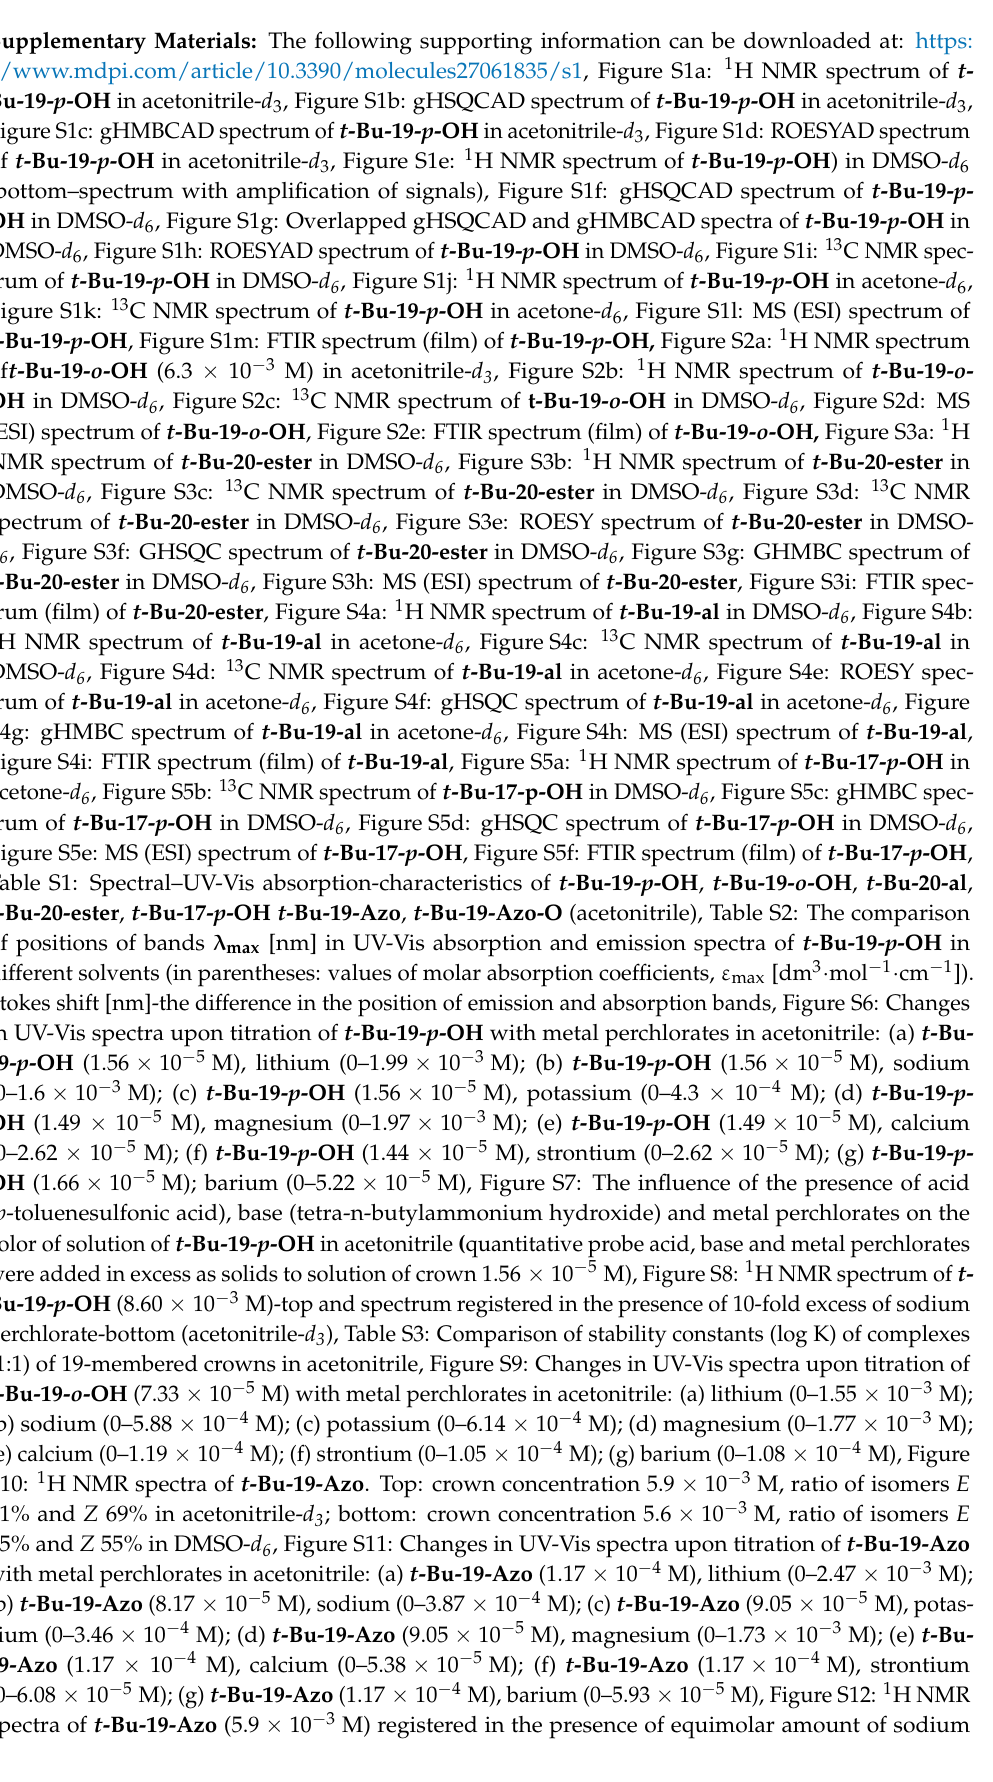
spectra of t -Bu-19-Azo (5.9 × 10 − 3 M ) registered in the presence of equimolar amount of